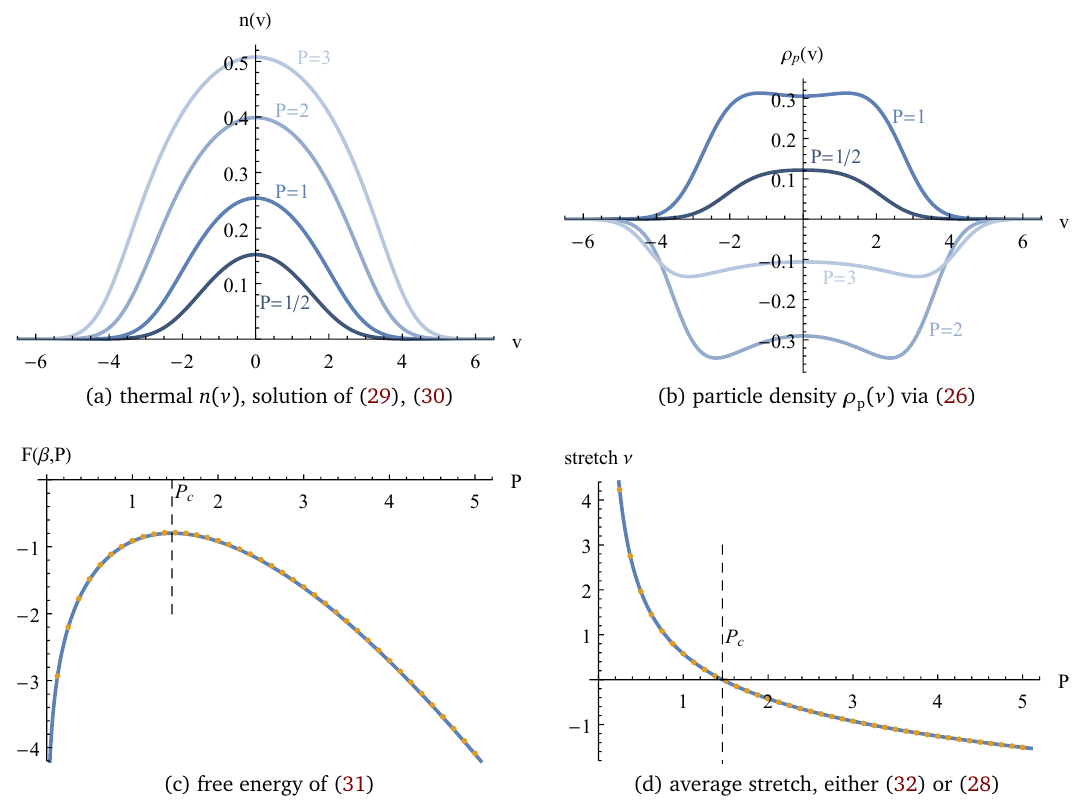
Figure 1: Thermal states for inverse temperature β = 1. (a) The number density n ( v ) as obtained by solving the TBA equation (29) with normalization (30), for different ( v ) diverges at P values of P . (b) The corresponding particle density ρ and flips its p c overall sign as P crosses P . (c) Free energy (31), which coincides with the chemical c potential µ appearing in (29). As consistency check, the yellow dots show µ obtained by inserting the Fokker-Planck stationary solution, (35), scaled by P into (29). (d) Average stretch: the solid line shows (32) and yellow dots the stretch computed via